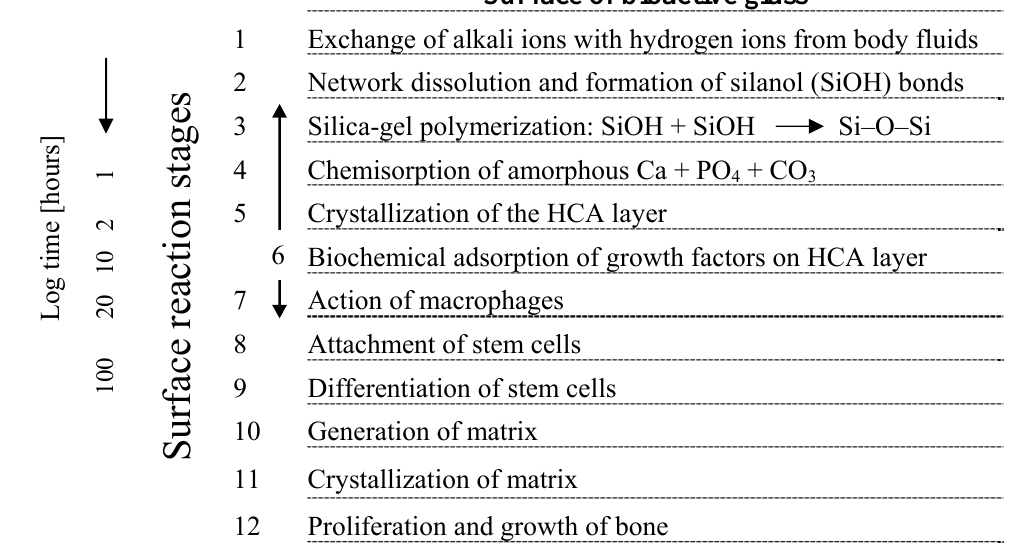
Figure 1. Sequence of interfacial reactions involved in forming a bond between bone and a bioactive glass (modified after reference